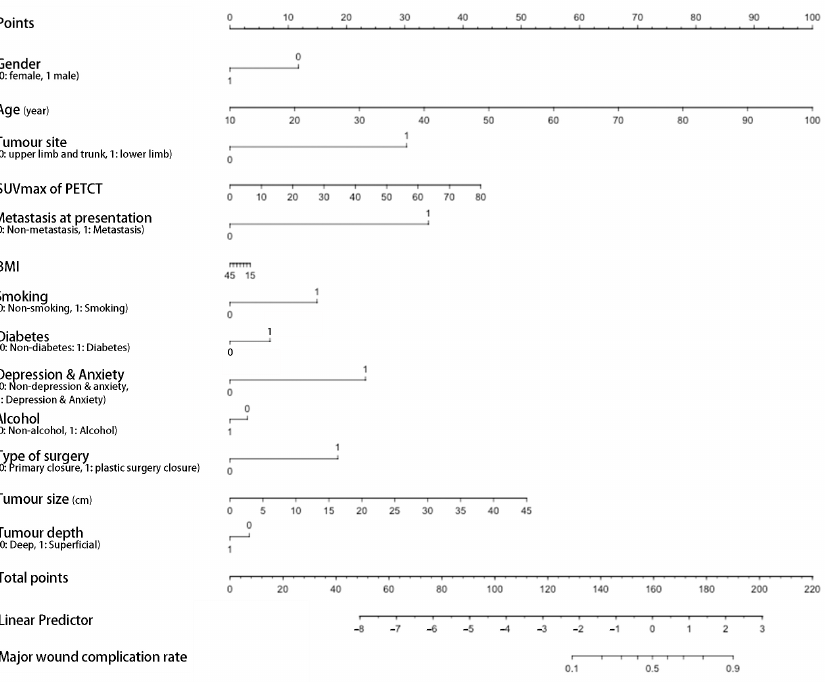
Figure 2. Decision curve analysis results of the nomograms. Net benefit curves of two predictive models. “None” line means net benefit when no participant is considered as having the outcome (major wound complication); “All” line means net benefit when all participants are considered as having the outcome. The preferred model is the model with the highest net benefit at any given threshold.